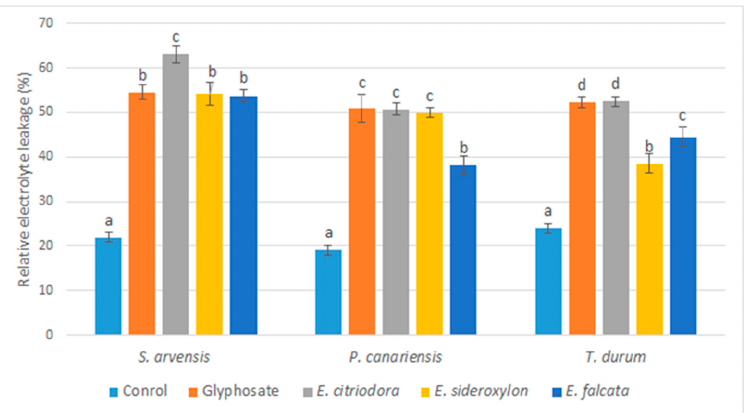
Figure 6. Effects of Eucalyptus essential oils and glyphosate on relative electrolyte leakage percent- age of tested plants measured five days after spray. The errors bars and letters on graphs represent standard errors means and significant differences at p ≤ 0.05 through Student–Newman–Keuls.